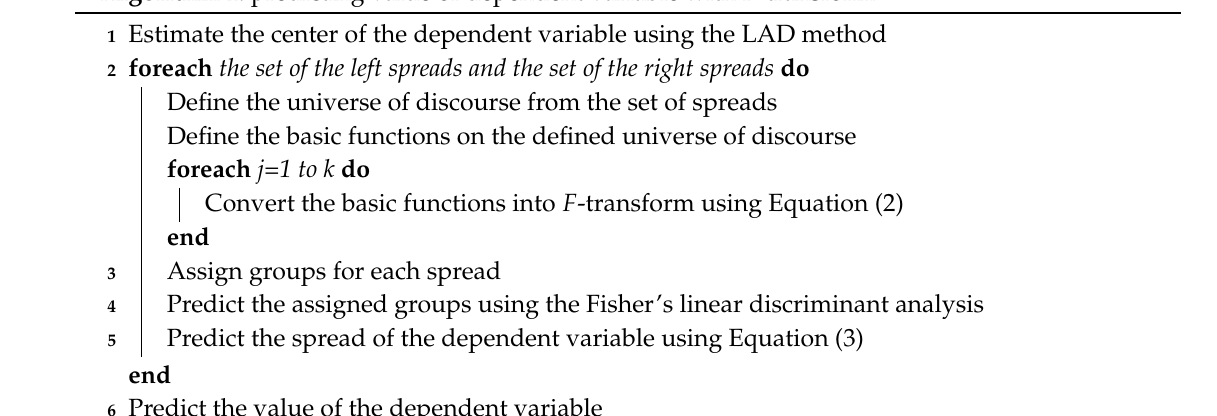
Algorithm 1: predicting value of dependent variable with F